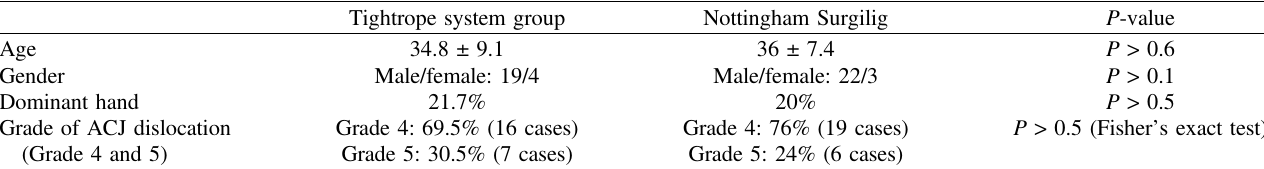
Table 1. Univariate predictors for radiographic failure. Tightrope system